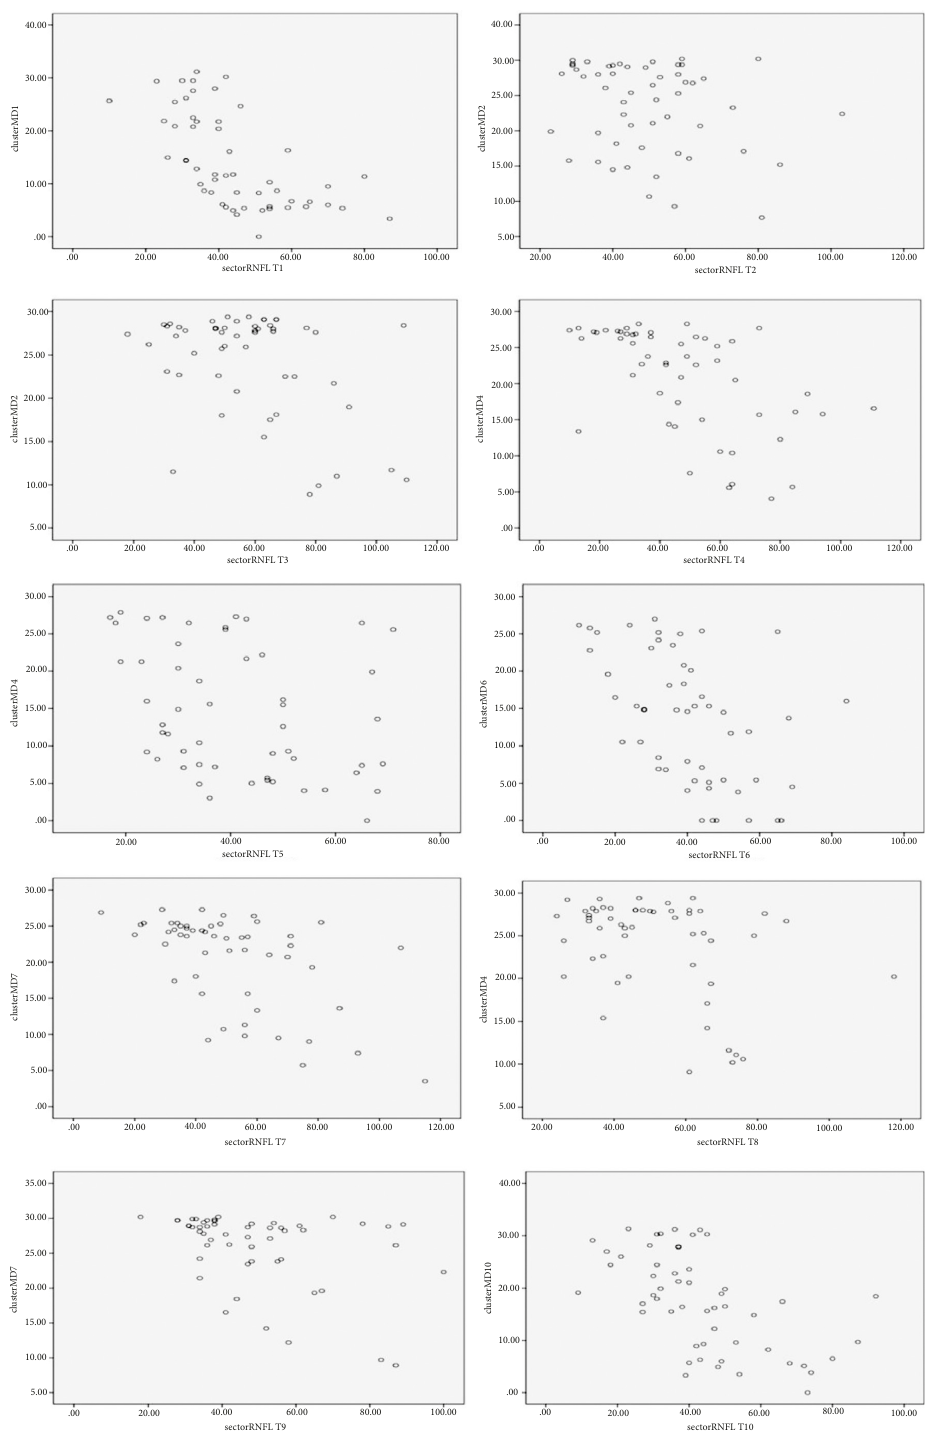
Figure 3: Scatter plots of sector peripapillary retinal nerve fiber layer thickness (pRNFLT, μ m) and cluster mean defect (cluster MD, dB) for 10 cluster-sector pairs in the advanced group ( n �